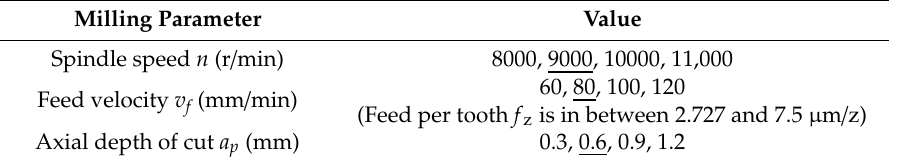
Table 1. Milling parameters of the single-factor experiment.